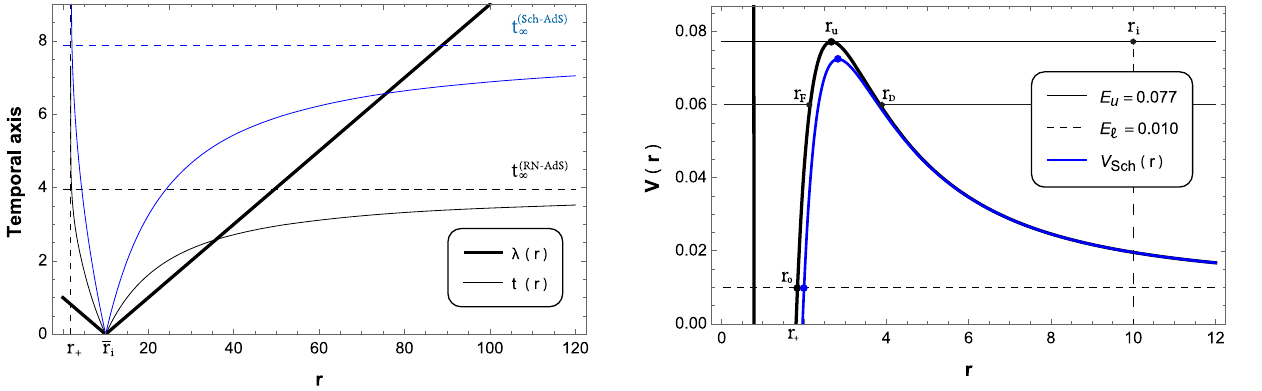
Fig. 3 Plot of the effective potential of photons. Here we have used the values L = 1, M = 1, (cid:4) = 10, r i = 10, Q = 1 . 2 (black line), and Q = 0 (blue